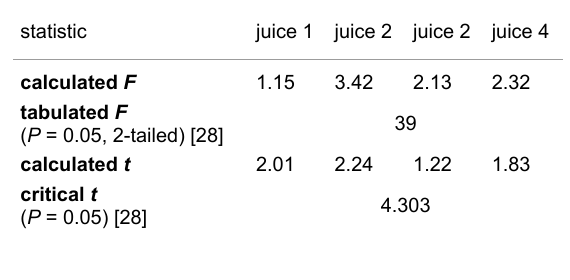
Table 3: Comparison of the results of SWV and HPLC methods.